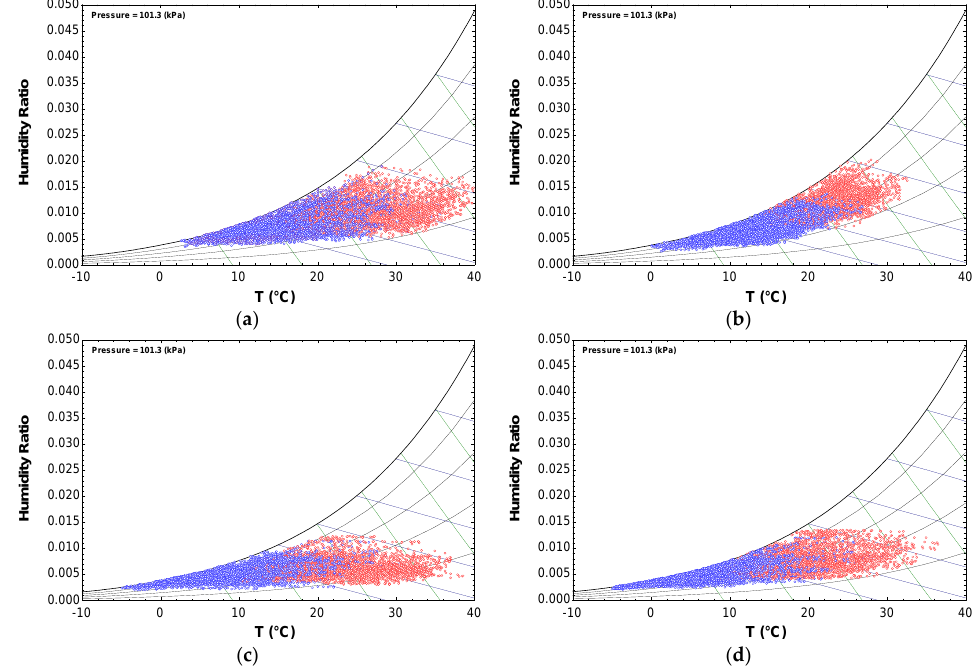
Figure 5. Hourly climatic conditions (blue: October-May, red: June–September) for ( a ) Seville; ( b ) Barcelona; ( c ) Madrid; and ( d ) Burgos.